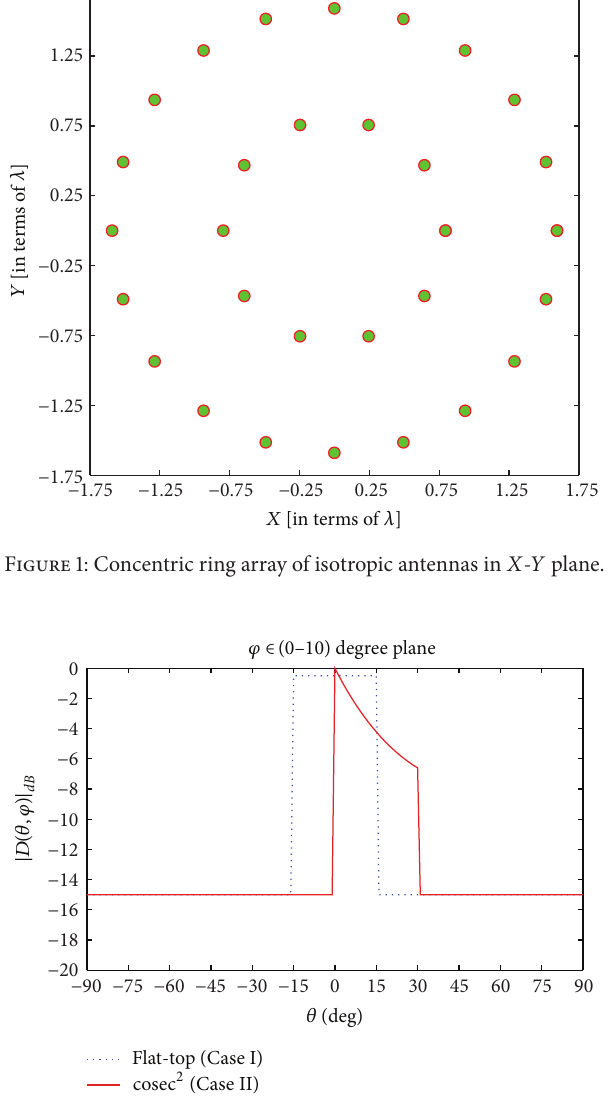
Figure 2: Desired patterns under two different design cases.